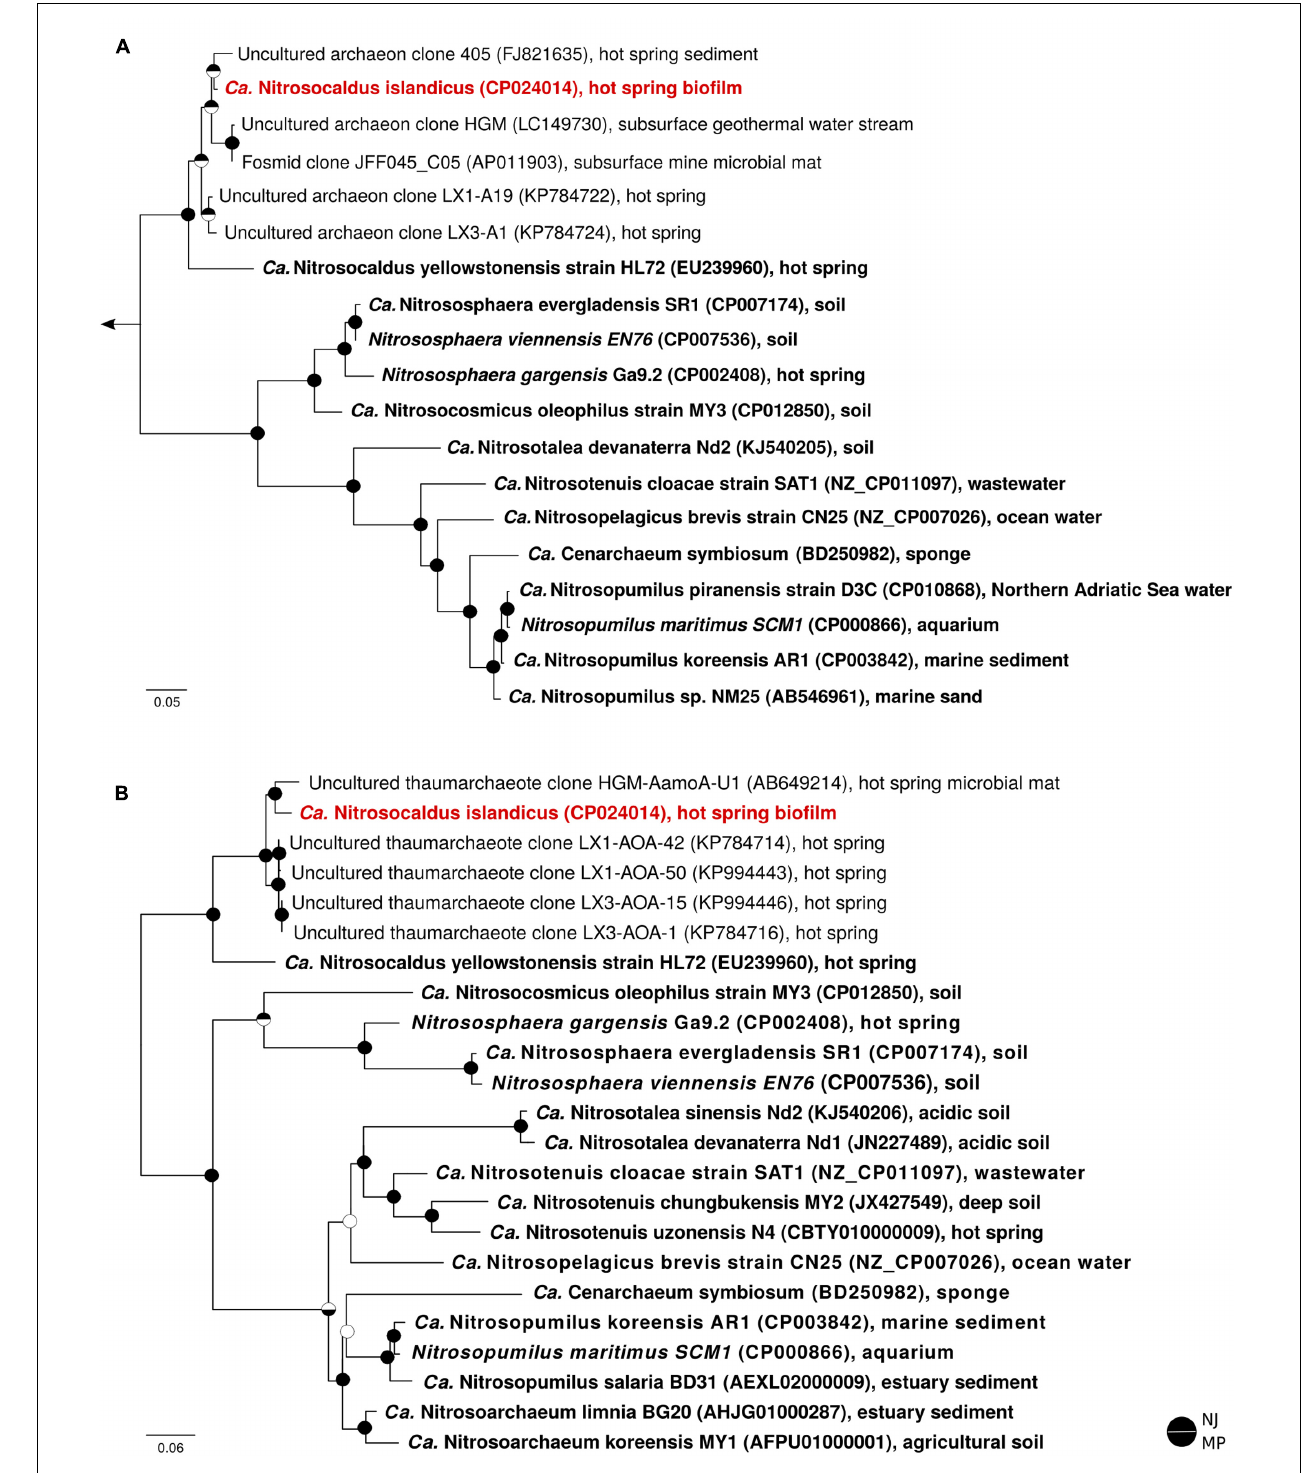
FIGURE 2 | 16S rRNA gene-based (A) and amoA gene-based (B) maximum likelihood phylogenies of representative thaumarchaeotal sequences. For each sequence, the accession number and environmental source are indicated. Sequences from pure and enrichment cultures are depicted in bold, and “ Ca . N. islandicus” is highlighted in red. The outgroup for the 16S rRNA tree were aigarchaeal sequences; the amoA phylogeny was calculated unrooted, but artificially rooted to the Nitrosocaldales afterwards. Circles at nodes denote support (filled) or no support (open) from Neighbour Joining (NJ, top half) and Maximum Parsimony (MP, bottom half) trees. The scale bars in (A,B) indicate 9 and 6% sequence divergence, respectively.